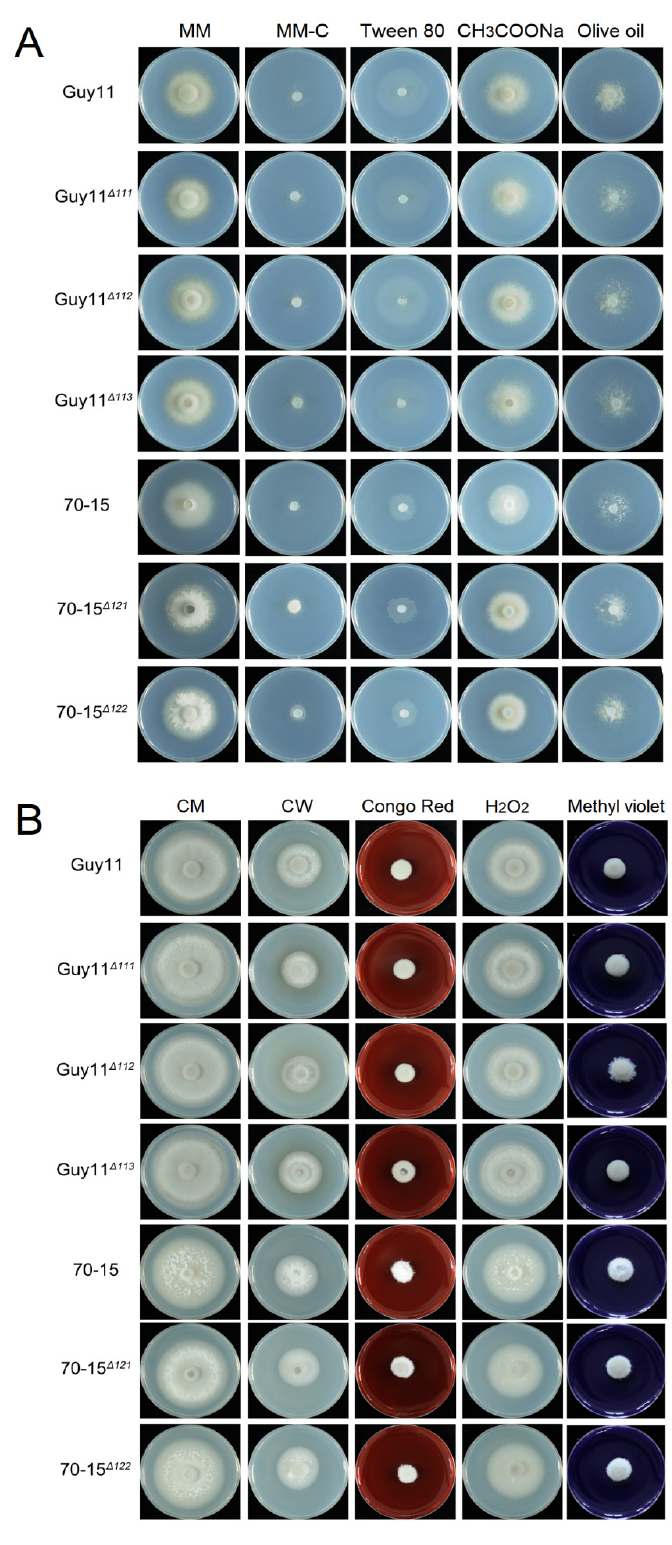
Figure 8. The carbon utilization, cell wall biogenesis and ROSs endurance were unaffected in the MAT gene deletion mutants. ( A ) The strains were cultured on MM; MM-C; and MM-C supplemented with 1% Tween 80, 50 mM CH 3 COONa or 1% Olive oil at 28 ◦ C for 7 days. ( B ) The strains were cultured on CM and CM containing 150 µ M calcofluor white (CW), 200 µ M Congo red, 0.1% hydrogen peroxide or 4 mM Methyl violet at 28 ◦ C for 7